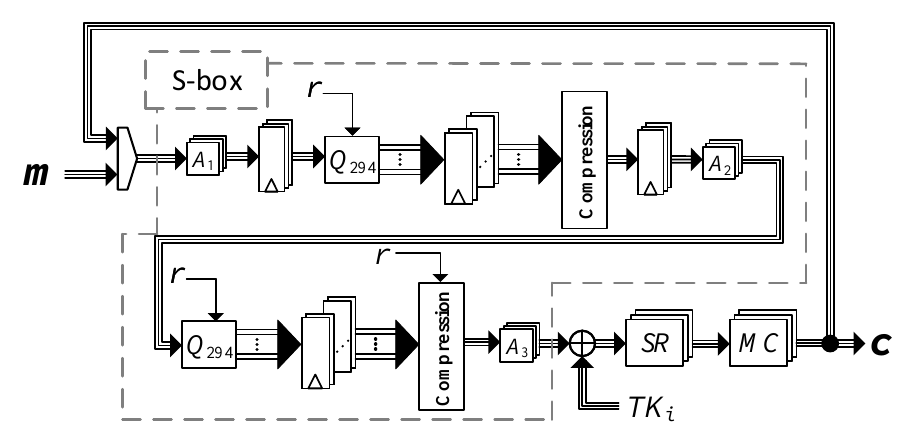
Figure 9: Design architecture of our round-based second-order Skinny -64 encryption